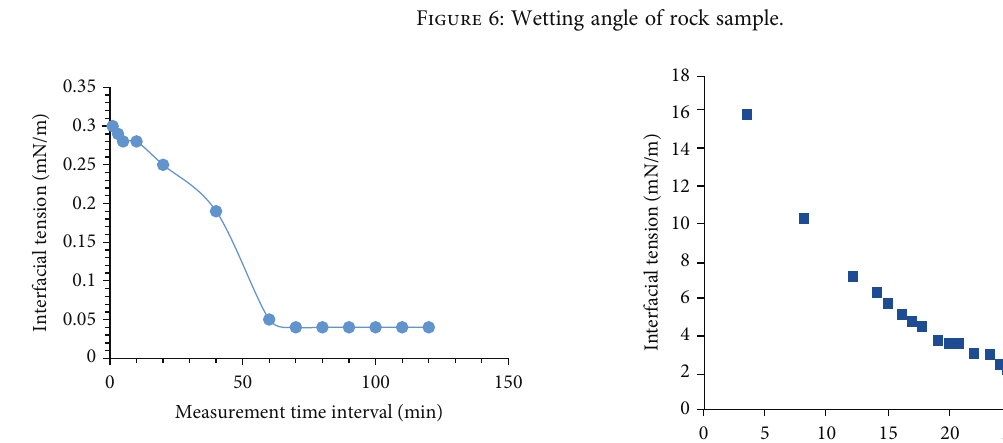
Figure 6: Wetting angle of rock sample.